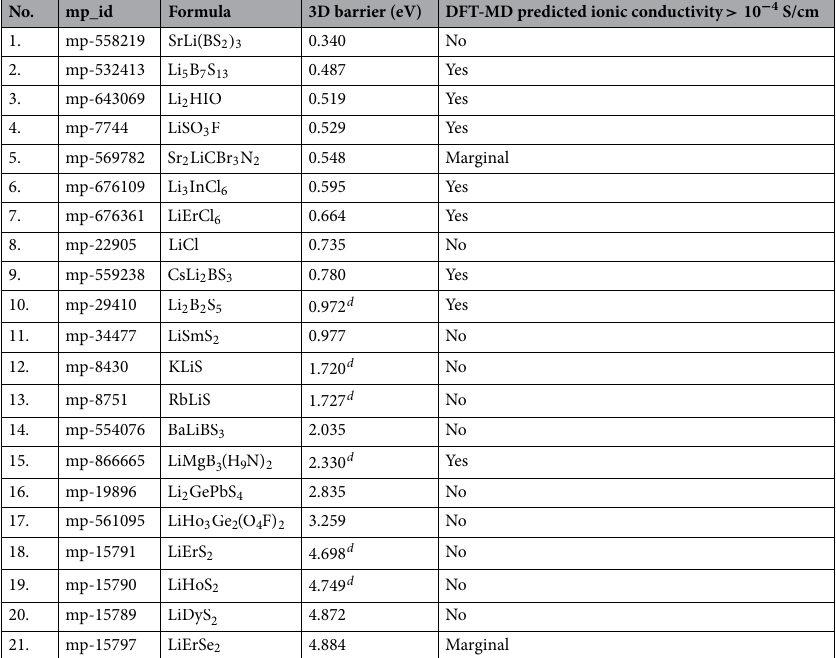
Table 4. Li compounds identified as possible superionic conductors by the Sendek model 59 are arranged in increasing order of their softBV 3D barriers. Where calculated barriers are missing, ML predictions are used instead. The rightmost column indicates whether the compound was predicted to have an ionic conductivity > 4 10 − S/cm based on high temperature DFT-MD simulations 60 .